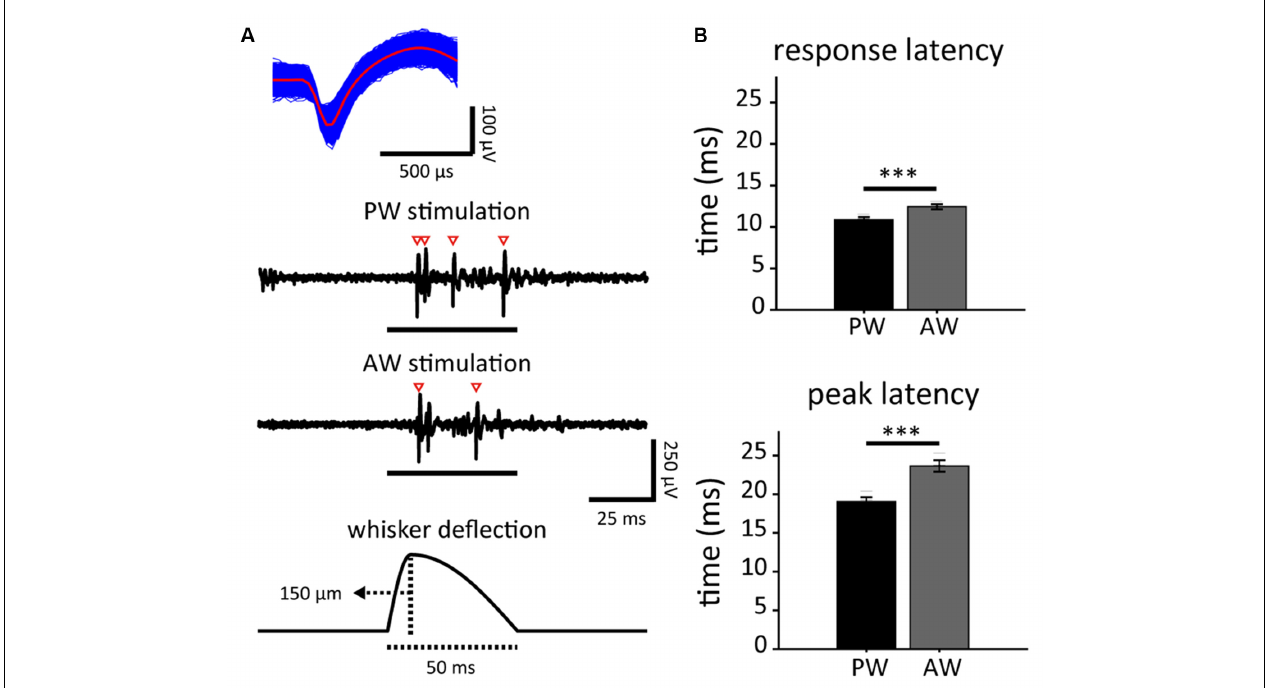
FIGURE 2 | Stimulus-driven activities in response to principal whisker (PW) and adjacent whisker (AW) stimulations, and the spontaneous neuronal activities in neuron populations. (A) The spike waveform of an example single unit (top) isolated from the spike trains as a response to stimuli presented to PW and AW (middle). Spikes are marked by empty arrowheads. Each whisker stimulus consisted of a 9-ms deflection and 41-ms restoration (bottom). (B) PW stimulation-induced shorter response latencies (top: response latency; bottom: peak latency; ∗∗∗ p < 0.001, Wilcoxon signed-rank test).